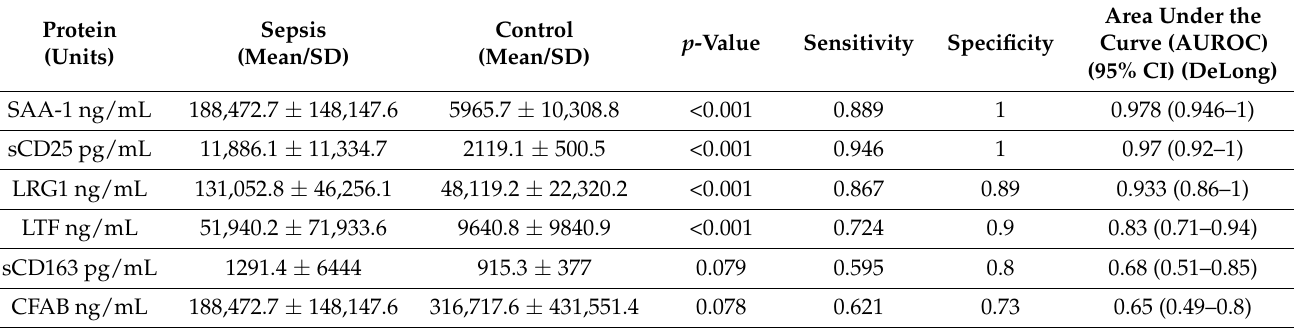
Table 2. ELISA-validated serum protein concentrations, sensitivity and specificity, and area under the curve (AUROC) for each protein.